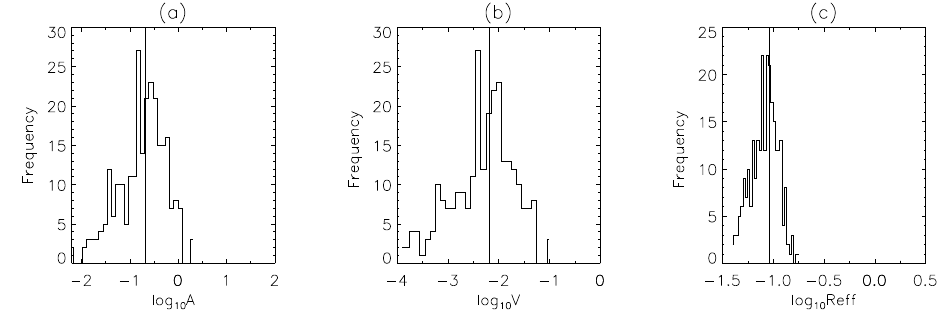
Fig. 2. Histograms of surface area density (a) , volume density (b) , and effective radius (c) as derived from the retrieved distribution parameters shown in Fig. 1. The vertical line indicates the a priori mean state.